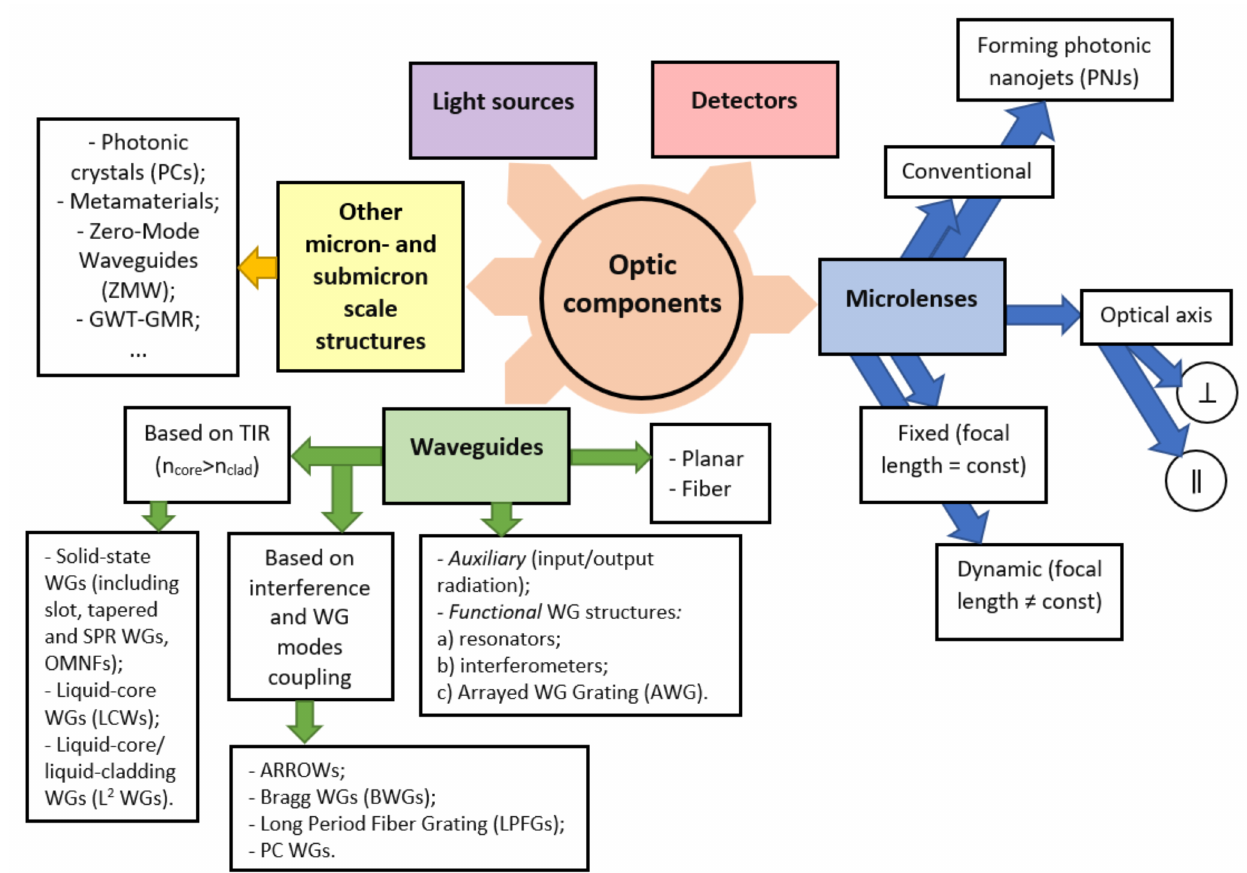
Figure 9. Optic components in microfluidics. (cid:107) —parallel, ⊥